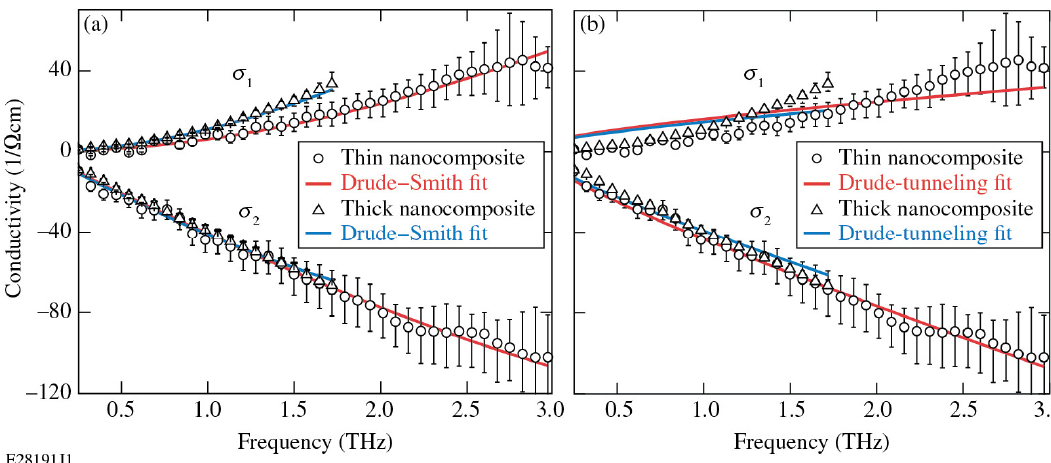
Figure 8. Experimental complex conductivity ( σ 1 and σ 2 ) spectra for both thin (open circles) and thick (open triangles), 1-wt% graphene nanocomposite samples. Solid lines correspond to the fits based ( a ) the Drude–Smith and ( b ) Drude-tunneling models. Experimental data points for the thick sample were trimmed according to sample bandwidth (see Figure 5b).